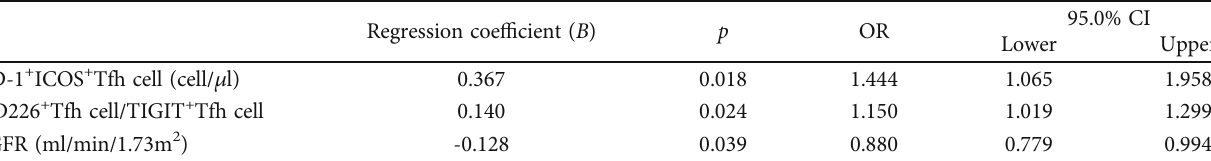
Figure 4: Correlation between di ff erent Tfh phenotypes, B cell subsets, and eGFR. Table 2: Logistic regression analysis for